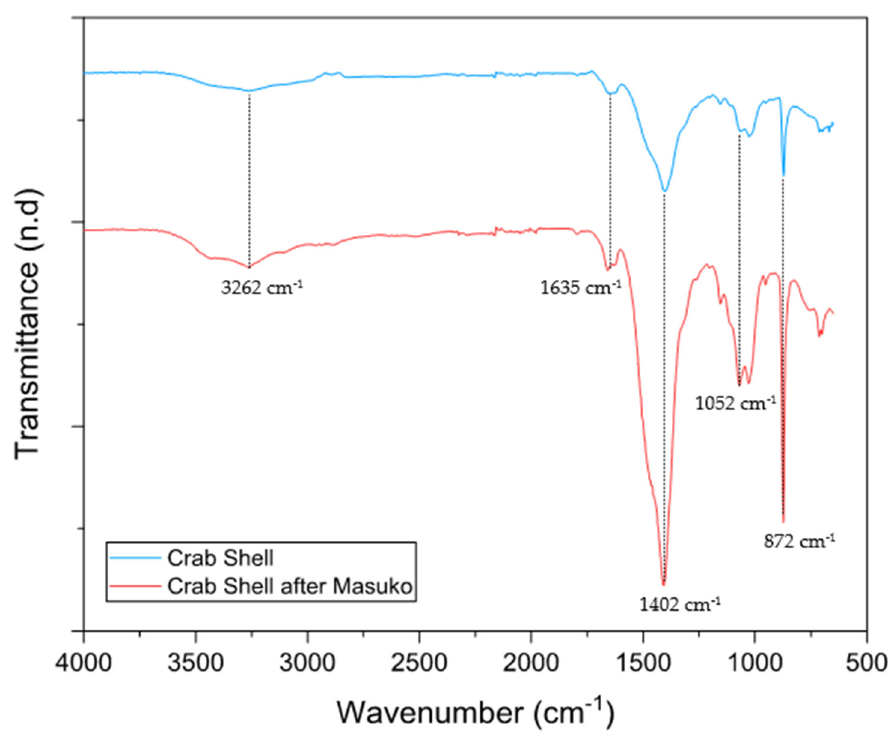
Figure 1. FTIR spectra of virgin carb shell and carb shell after grinding using Masuko Grinder. Wavenumbers at 3262, 1635, 1402, 1052 and 872 cm − 1 are attributed to NH stretching, –N–, H–CO stretching, NH 2 groups in protein, and calcium carbonate [37,38].